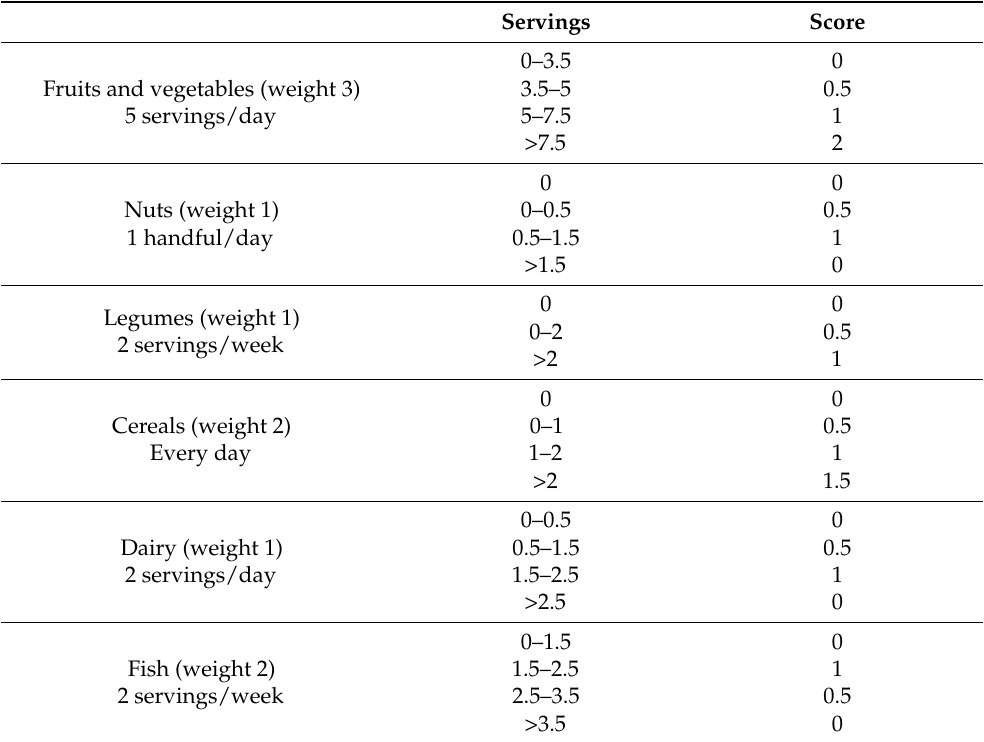
Table 1. Programme National Nutrition Sant é —guidelines score 2 (PNNS-GS2): components and